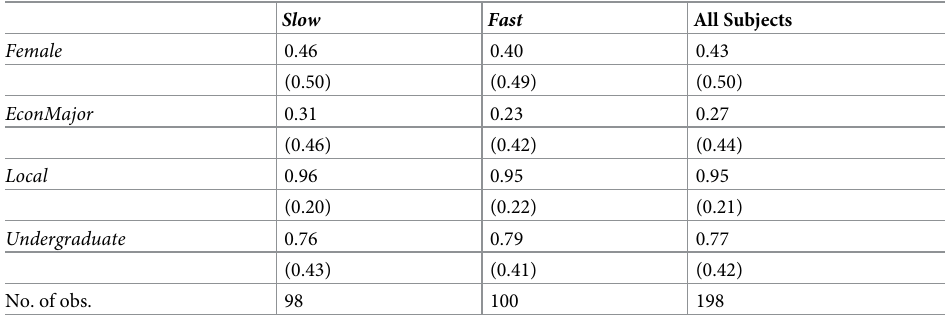
Table 1. Descriptive statistics of demographic